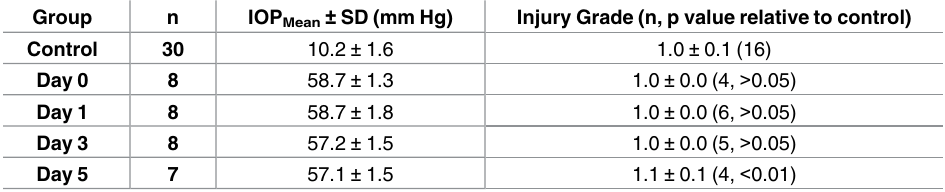
Table 1. Mean IOP Measurements During 8 Hours of IOP